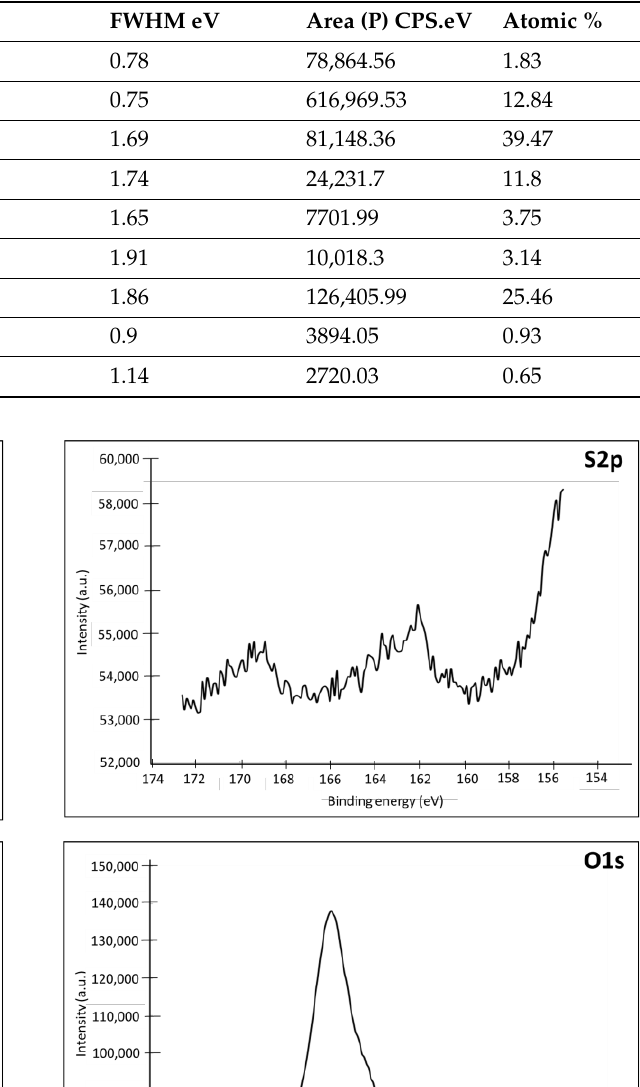
Table A3. Characteristics of the XPS peaks, attribution and atomic percentage for an Au surface modified with Product 7 after Click coupling.